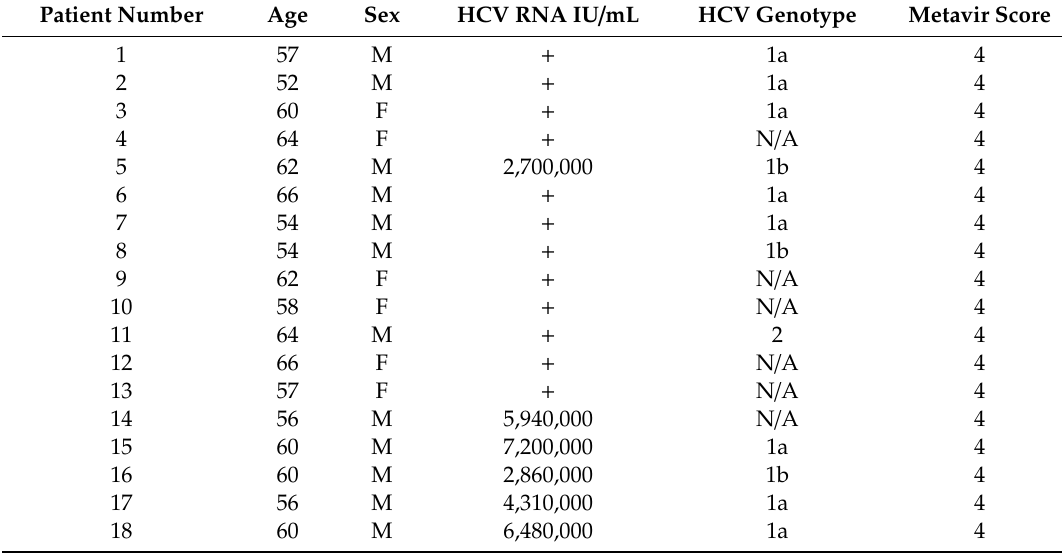
Table 2. Characteristics of the patients with